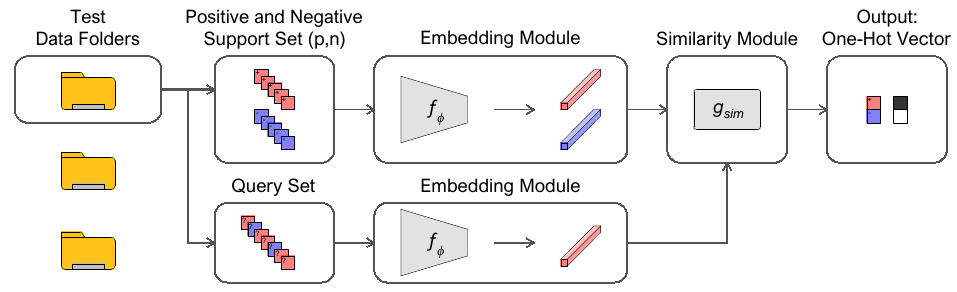
Figure 2. Open-set testing procedure of few-shot metric